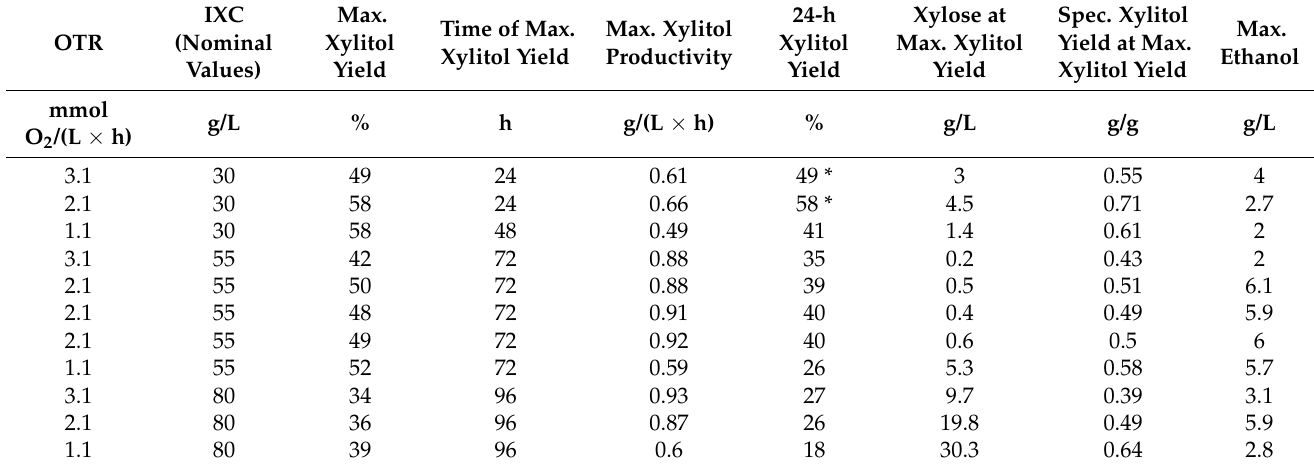
Table 2. Results of xylitol fermentation during the designed experiments (3 2 ) by using Candida boidinii NCAIM Y.01308. (OTR: oxygen transfer rate, IXC: initial xylose